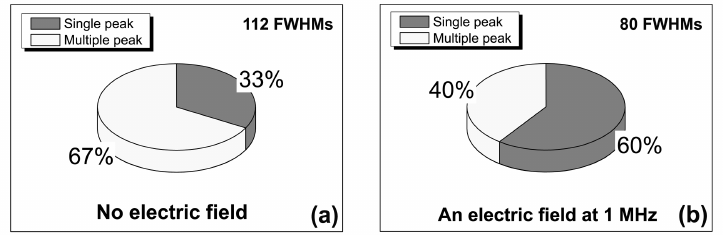
Figure 4. Populations of single and multiple peaks obtained from the 12 12 0 reflection ( a ) without application of an external electric field and ( b ) with an applied field at 1 MHz. Reproduced from reference [19], with the permission of AIP